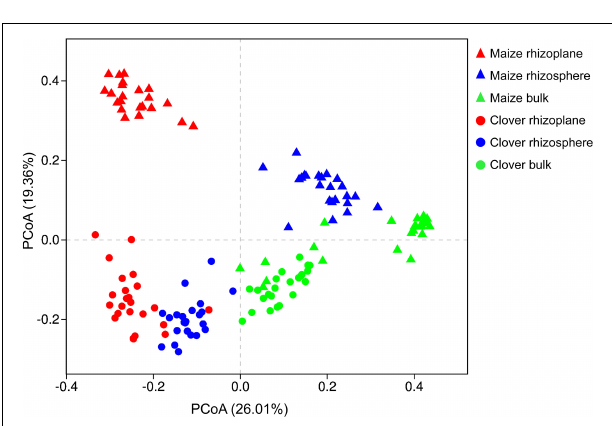
FIGURE 3 | Bacterial communities in different rhizocompartments (rhizoplane, rhizosphere, and bulk) of clover and maize plants. Principal coordinate analysis (PCoAs) plots of the OTU-based Bray–Curtis distance between all samples. The variance explained by each PC axis is given in